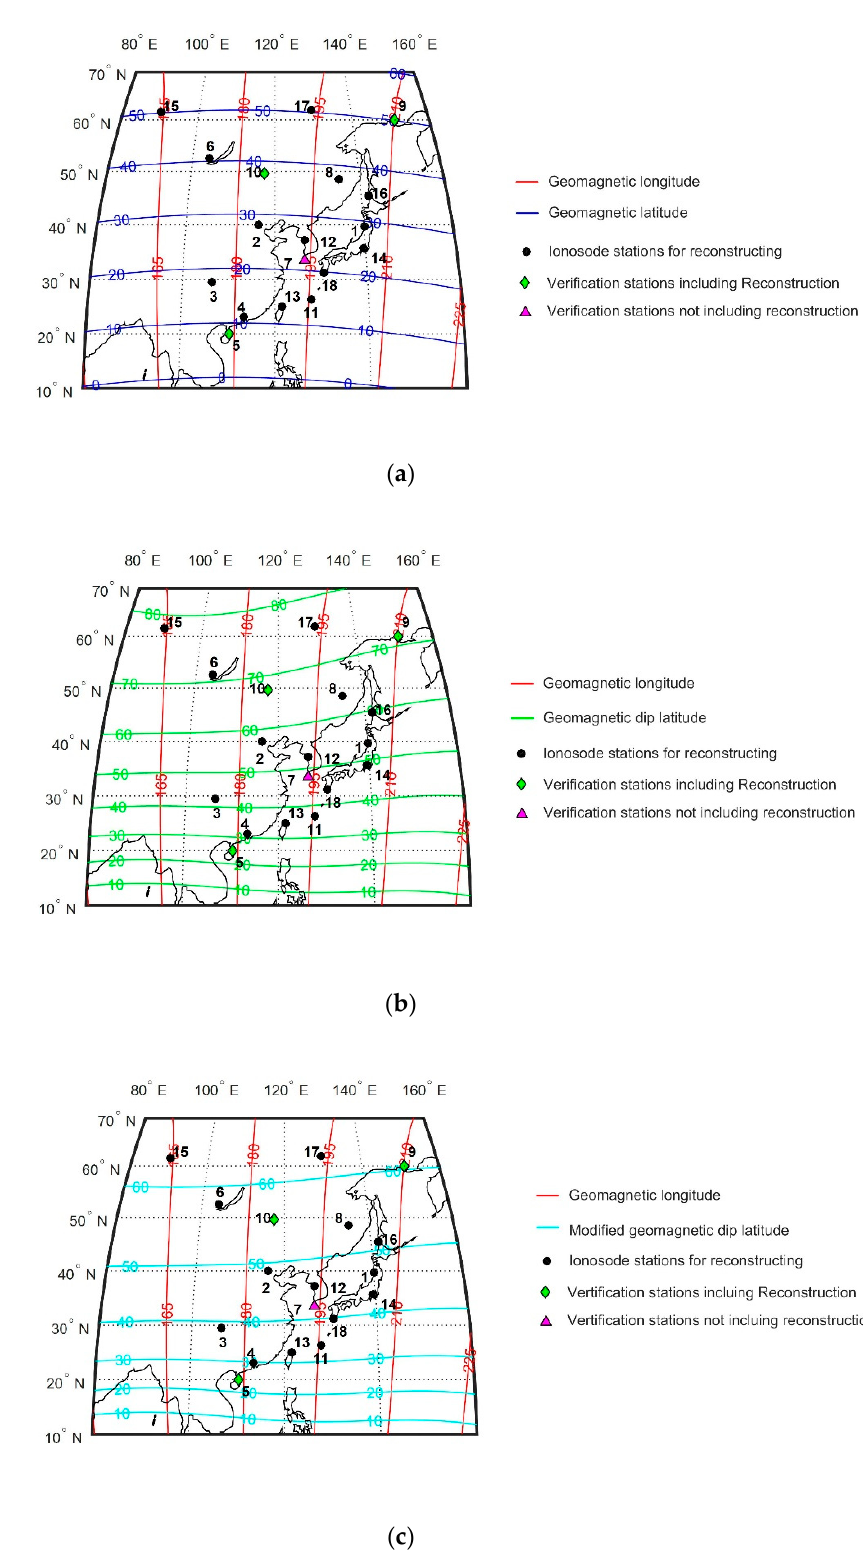
Figure 2. Comparison of geomagnetic and geographic coordinates in the analysis region. ( a ) Geographic coordinates and geomagnetic coordinates, ( b ) geographic coordinates and geomagnetic dip latitudes, and ( c ) geographic coordinates and modified geomagnetic dip latitudes.